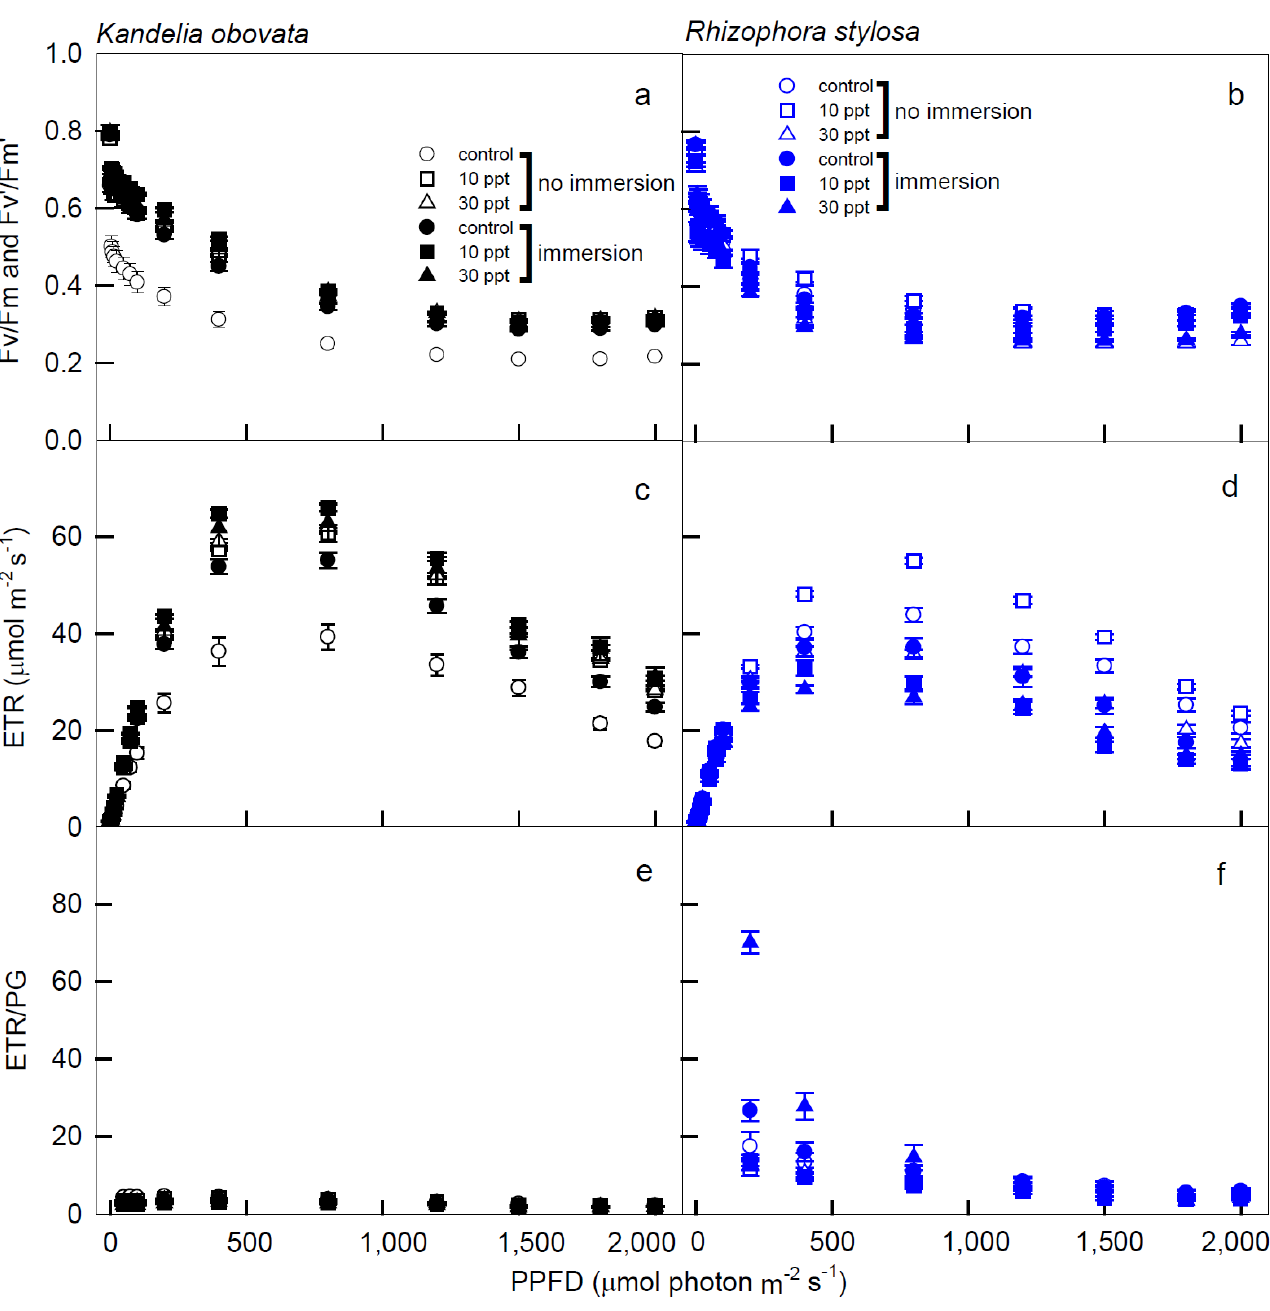
Figure 4. The light −response curves of Fv/Fm (Fv’/Fm’), electron transport rate (ETR), and electron transport rate/gross photosynthesis (ETR/PG) in K. obovata ( a , c , e ) and R. stylosa ( b , d , f ) seedlings cultivated under 0, 10, and 30 ppt of salinity with and without immersion conditions. Measurements were recorded at 25 °C with different PPFD at 0, 5, 10, 15, 25, 50, 75, 100, 200, 400, 800, 1200, 1500, 1800, and 2000 μmol photon·m −2 ·s −1 . Each data point represents the mean ±SE of 3 leaves from five replicates ( n = 15) for each salinity treatment.